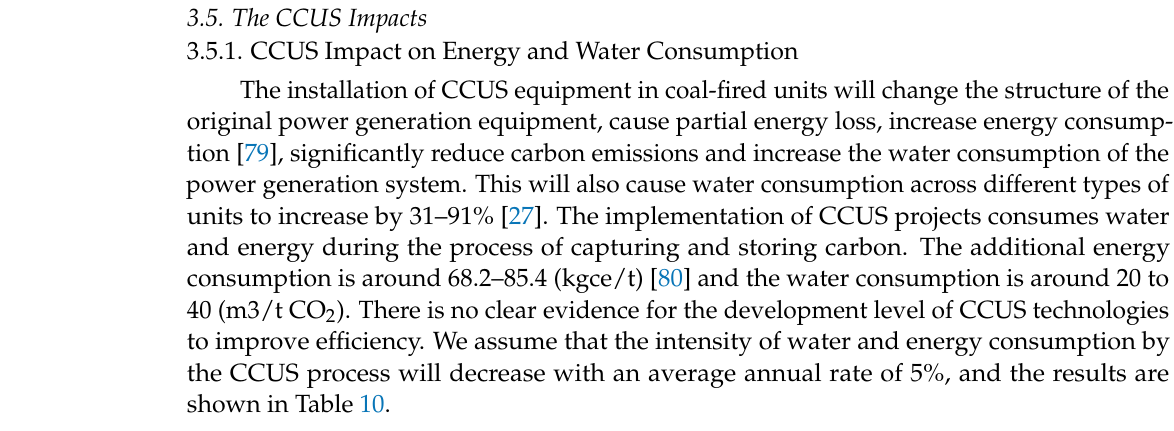
Table 10. Prediction of the increased water and energy consumption with